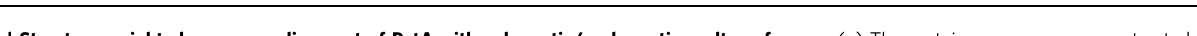
Figure 9 | Structure weighted sequence alignment of PatA with eukaryotic/prokaryotic acyltransferases. ( a ) The protein sequences were extracted from UniProt accession numbers A0QWG5 from M. smegmatis (PatA_Msmeg); P24205 from Escherichia coli (MSBB_ECOLI); O06659 from Shigella flexneri (MSBB2_SHIFL); P0ACV0 from E. coli (HTRB_ECOLI); P45239 from Haemophilus influenzae (HTRB_HAEIN); P10349 from C. moscata (GPAT_CUCMO); Q43869 from Spinacia oleracea (GPAT_SPIOL); P0A7A7 PlsB from E. coli (PLSB_ECOLI); Q7UBC6 PlsB from S. flexneri (PLSB_SHIFL); O80437 from Arabidopsis thaliana (GPAT6_ARATH); O15228 from Homo sapiens (DHAPAT_HUMAN); Q8L7R3 from Arabidopsis thaliana (LPCT1_ARATH); Q99943 from H. sapiens (PLCA_HUMAN); and Q53EU6 from H. sapiens (GPAT3_HUMAN). Conserved positions are shown in black and grey background. Conserved hydrophobic residues are indicated with an h . The secondary structural elements corresponding to the 3D structure of PatA are shown above the alignment. Catalytic amino acids and those involved in palmitate binding are indicated as asterisks and black circles, respectively. ( b ) Structural similarity of M. tuberculosis H37Rv and M. smegmatis mc 2 155 PatA. Catalytic amino acids are indicated as asterisks. Amino acids involved in palmitate and pantotheinate binding are indicated as black and white circles, respectively. Residues proposed to interact with PIM 1 and PIM 2 based on the dockings are shown as white and black triangles, respectively. Amino acids mutated are